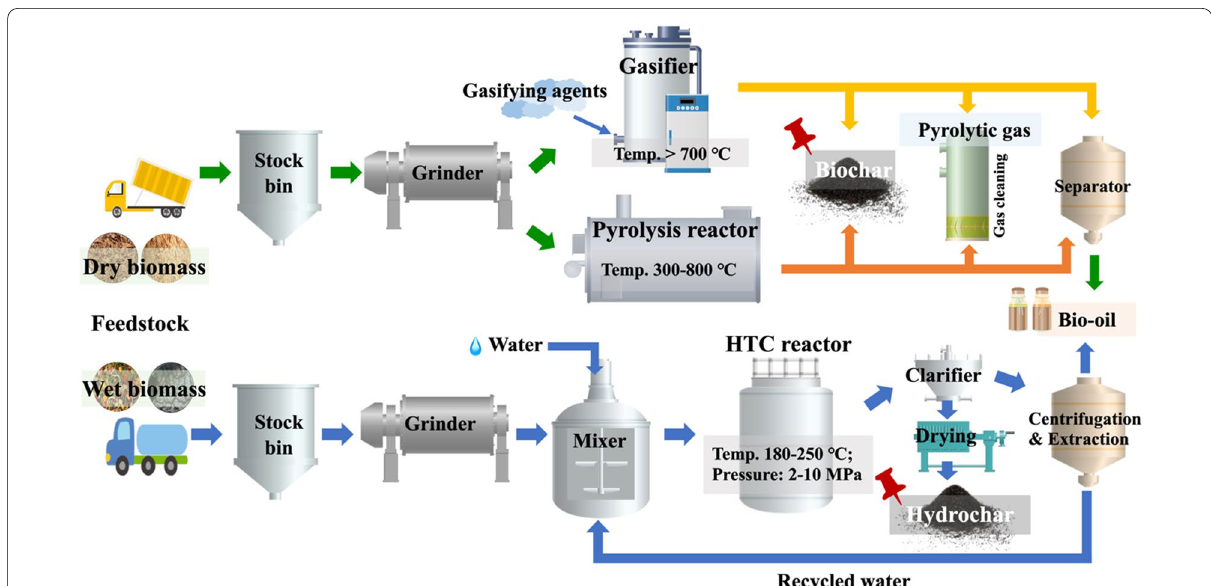
Fig. 2 Pyrolysis and hydrothermal carbonisation of biomass for biochar